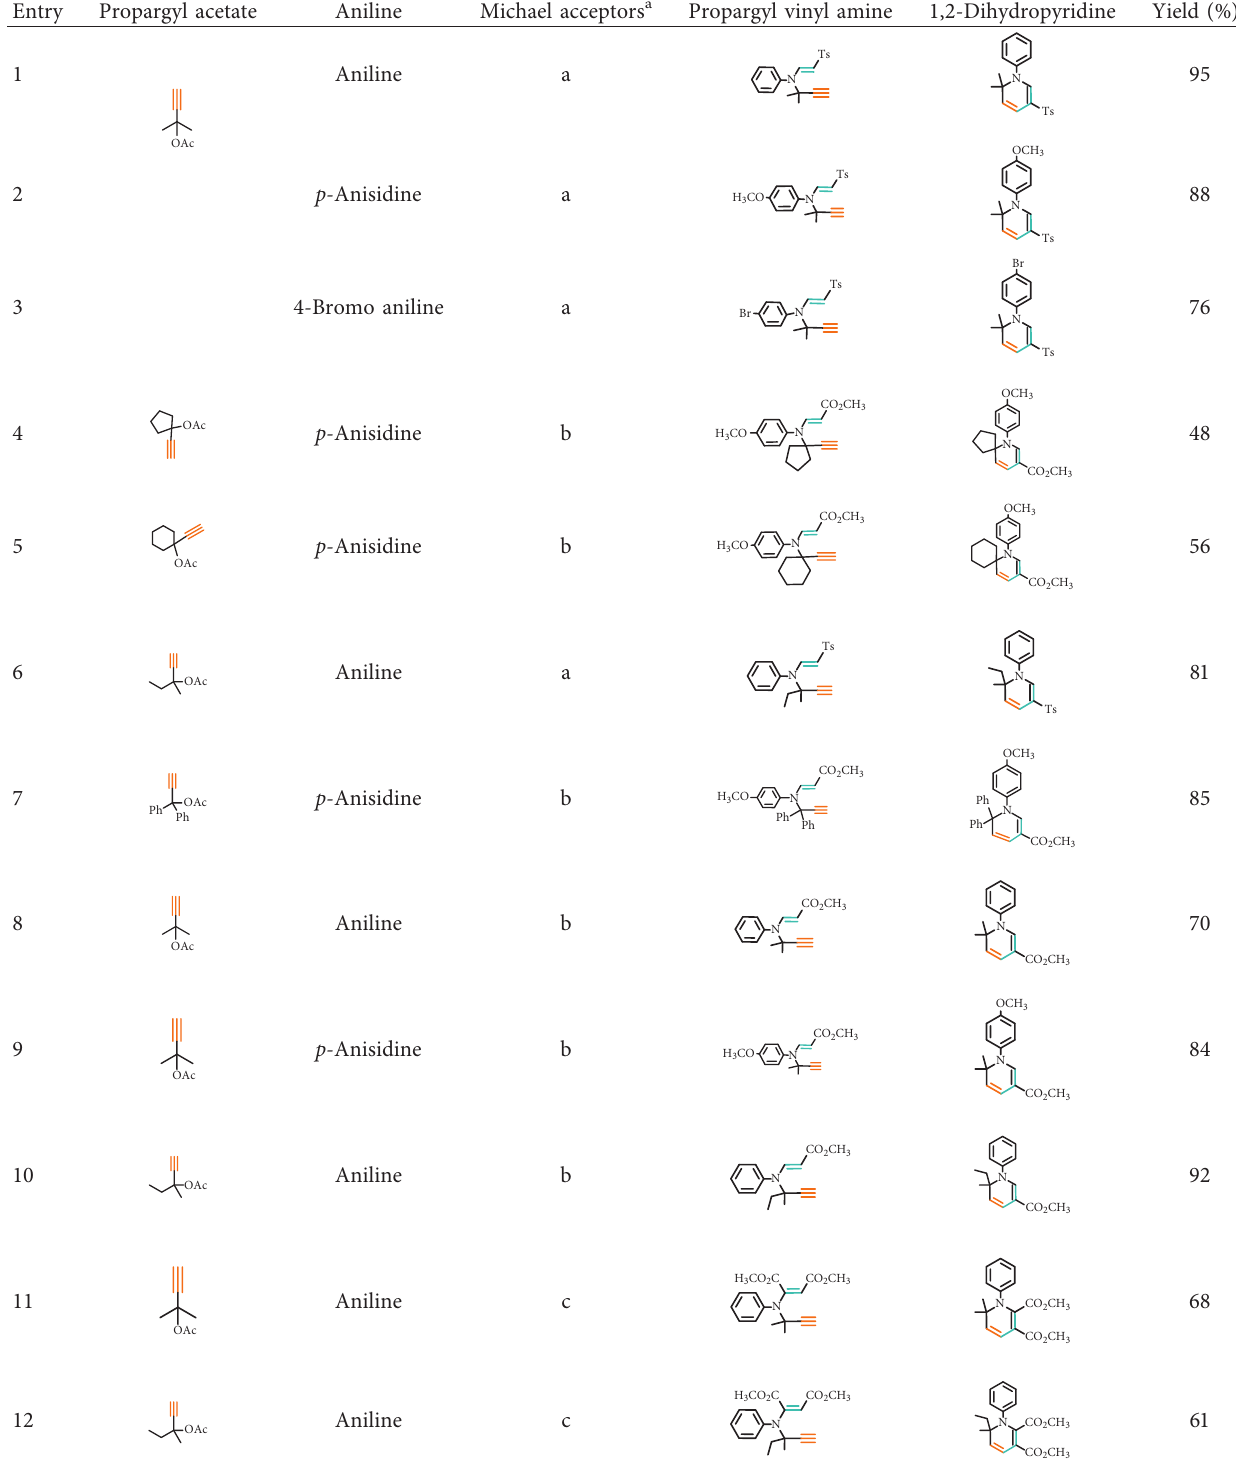
Table 2: Scope of the annulation reaction of N -propargyl vinyl